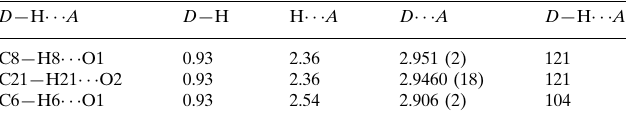
Hydrogen-bond geometry (A˚ , (cid:1)